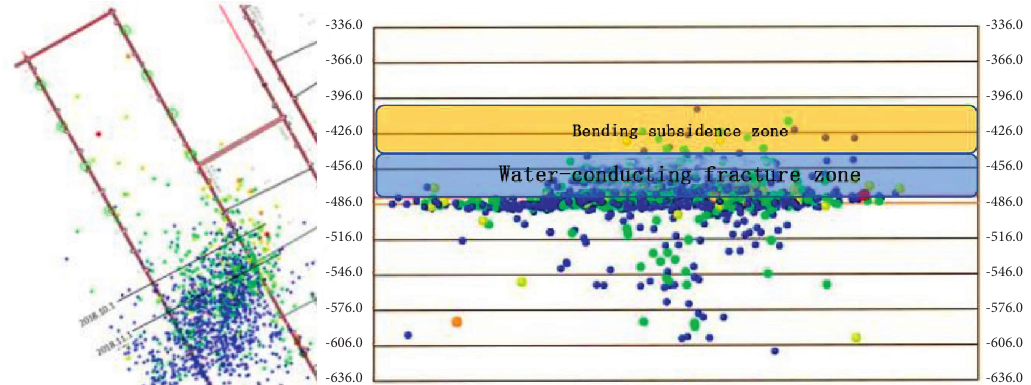
Figure 9: Plan and profile of the 16001 working face microseismic event distribution in the stage after the square stage. Table 3: The energy percent of three stages. The percent of energy event in stage before Energy (J) the square stage (%)